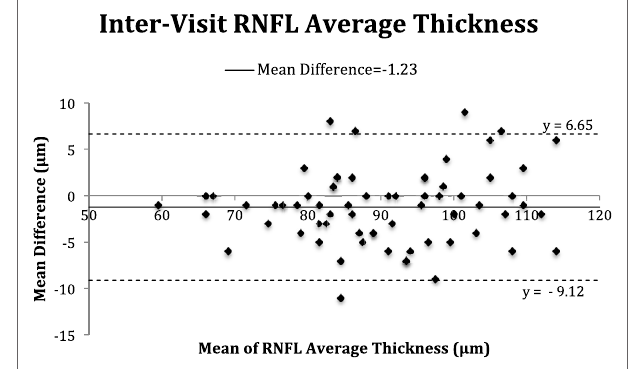
FigUre 3 | Bland–Altman plot of inter-visit peripapillary retinal nerve fiber layer (RNFL) thickness.